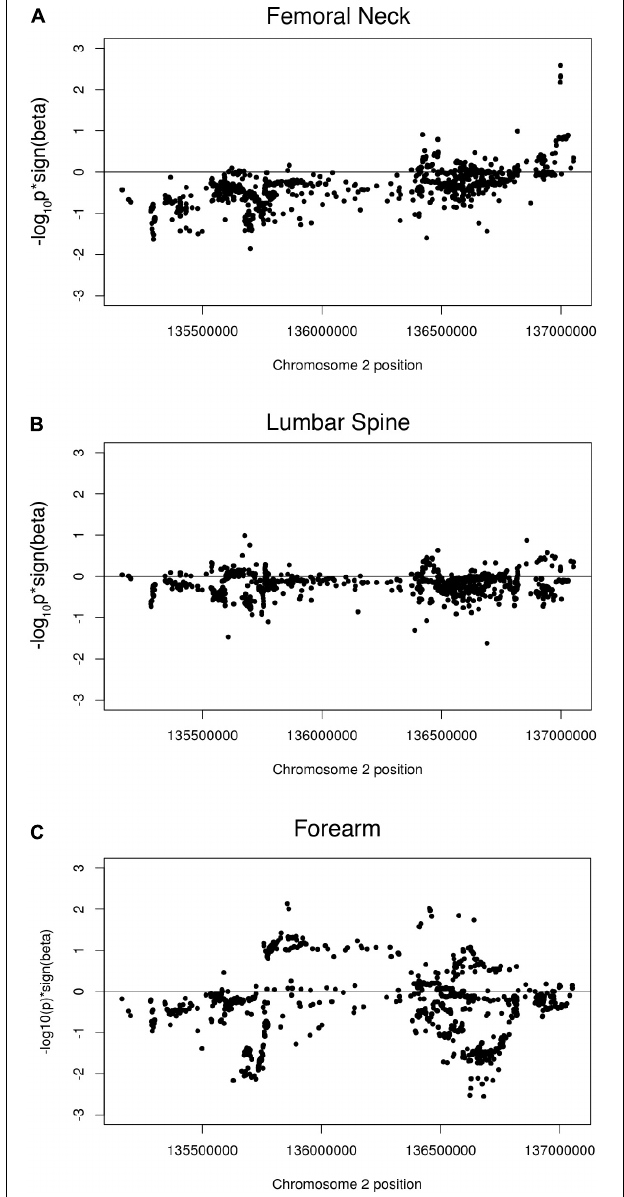
FIGURE 3 | Wilcoxon rank sum tests showing beta signed p -values for (A) femoral neck BMD associated SNPs in high LD with the lactase persistence SNP; (B) lumbar spine BMD associated SNPs in high LD with the lactase persistence SNP and (C) forearm BMD associated SNPs in high LD with the lactase persistence